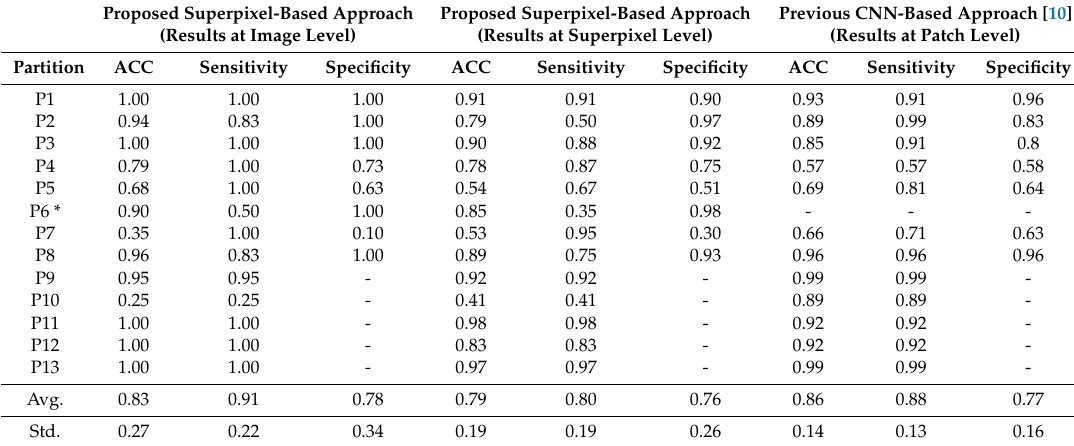
Figure 13. Average image classification results per patient in the test set using the SVM Linear kernel optimized with the BA metric. P9 to P13 only have samples from tumor class. Table 2. Results comparison between the proposed superpixel-based approach and a previous work using a CNN-based approach